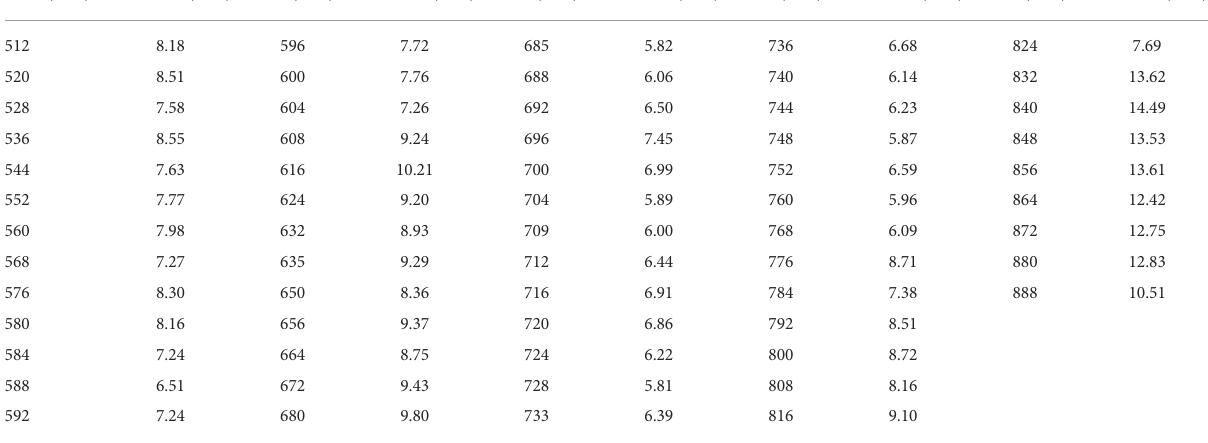
TABLE 2 Central wavelength (WL) and full width at half maximum (FWHM) of the used hyperspectral